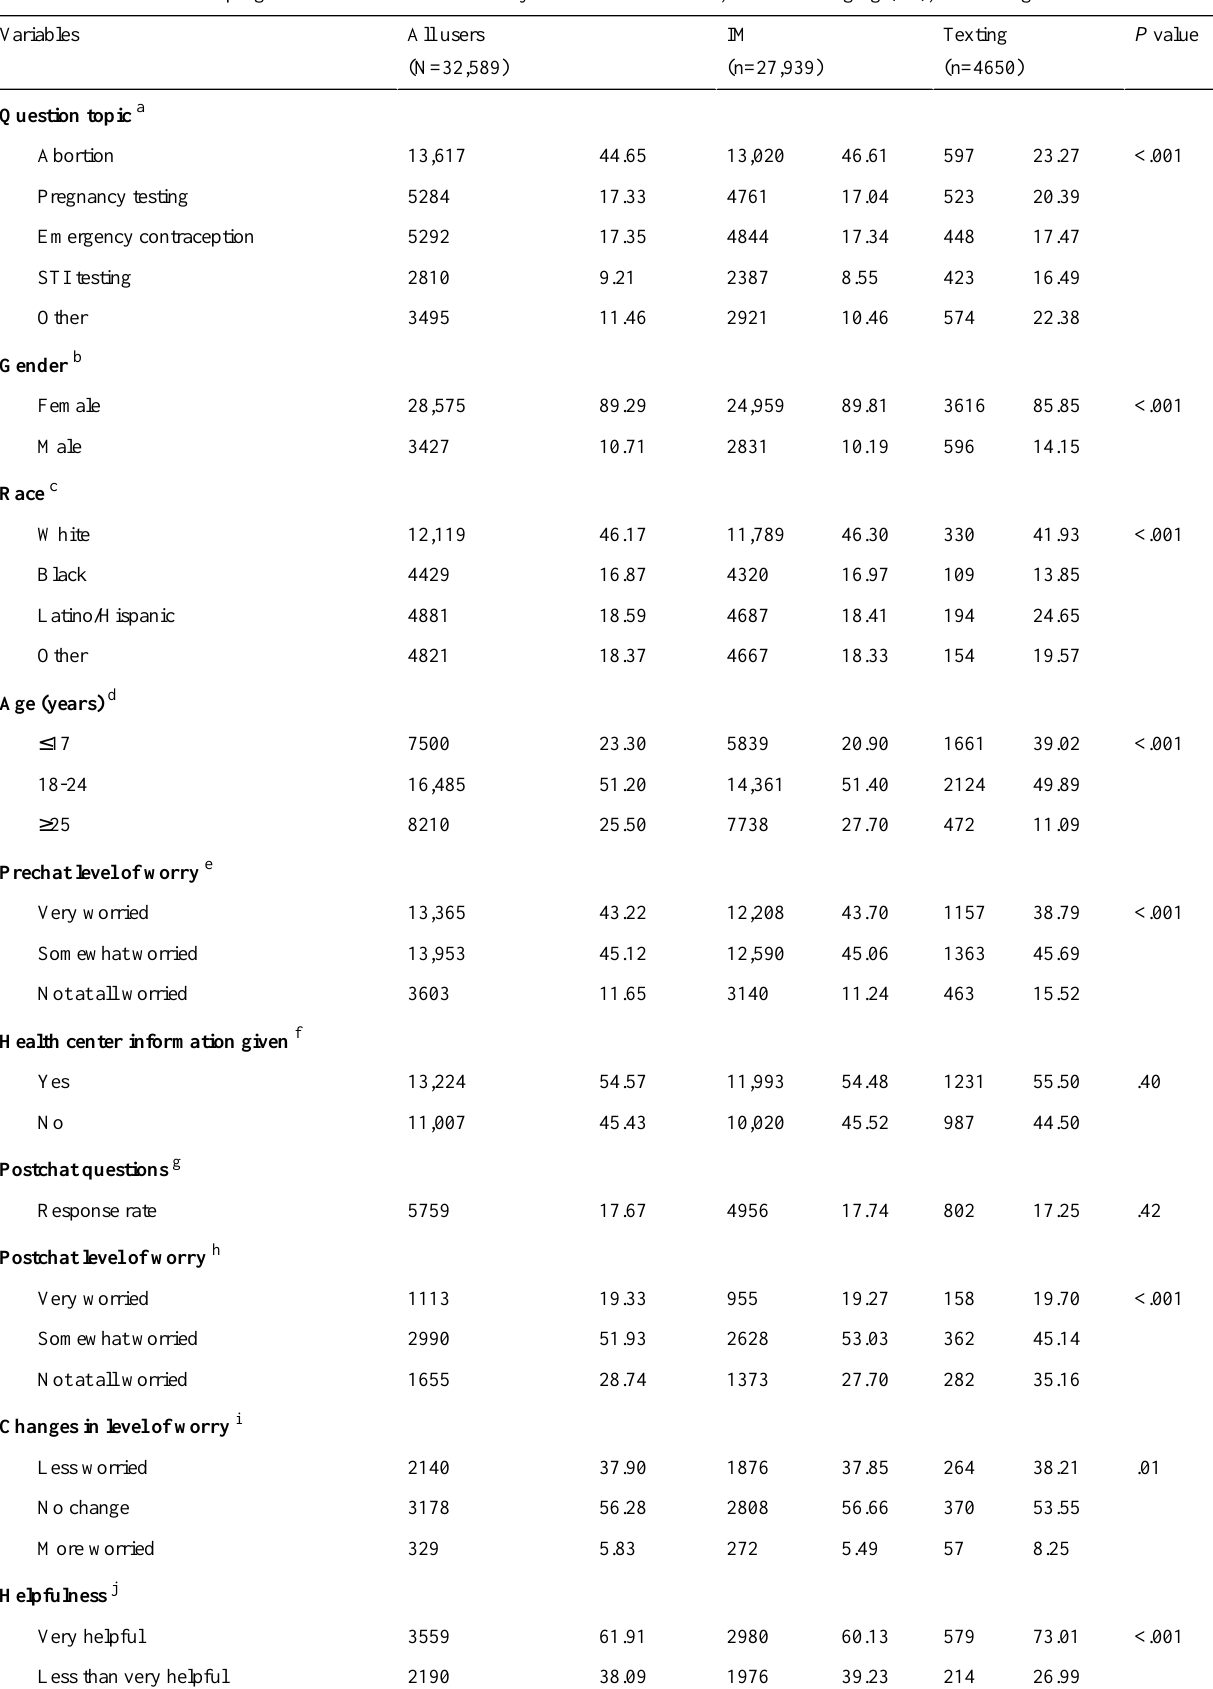
Table 2. Characteristics of program users and conversations by mode of conversation, instant messaging (IM), and